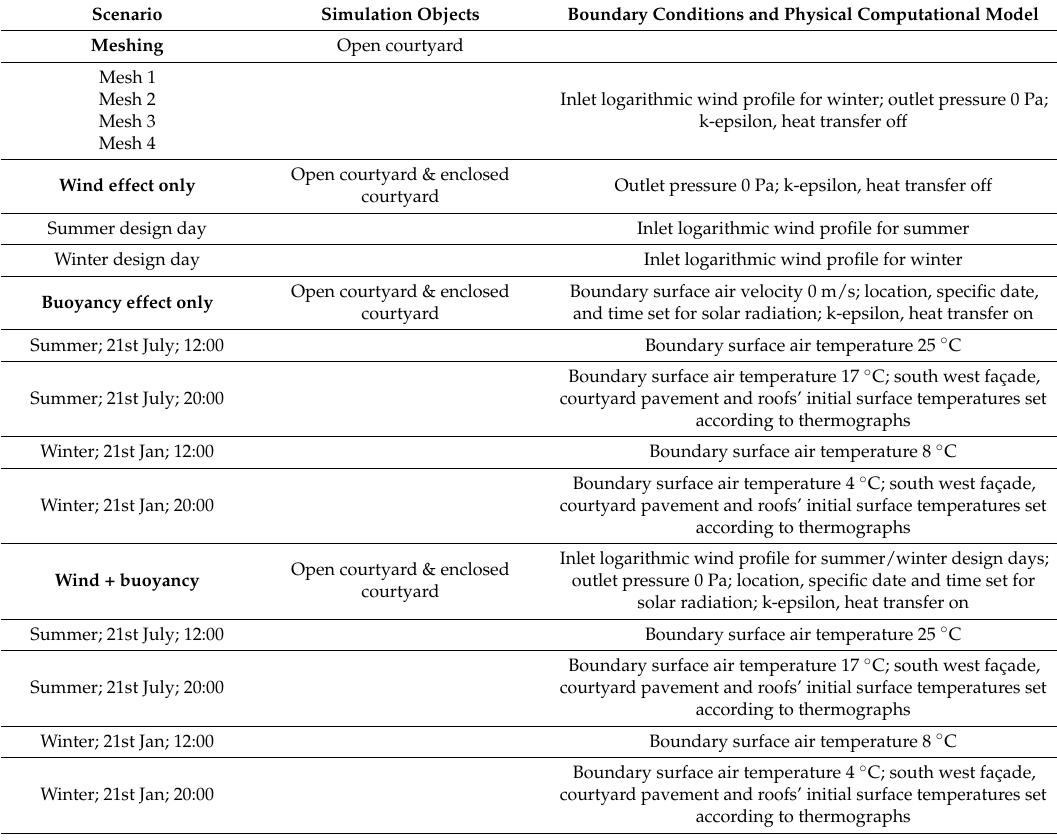
Figure 12. Daily activities taking place in the semi-open spaces of a courtyard house: ( a ) farm work, ( b ) open-market retailing, and ( c ) socializing .